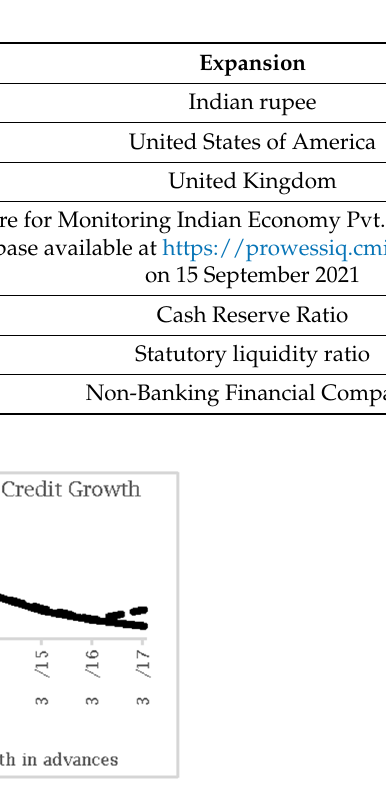
Figure A1. This shows the trends in deposits and advances for the last 10 years.